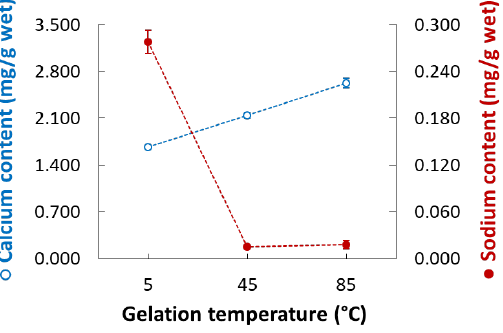
Figure 3. Calcium (open circles) and sodium ion (filled circles) content of CAG beads prepared at di ff erent gelation temperatures.